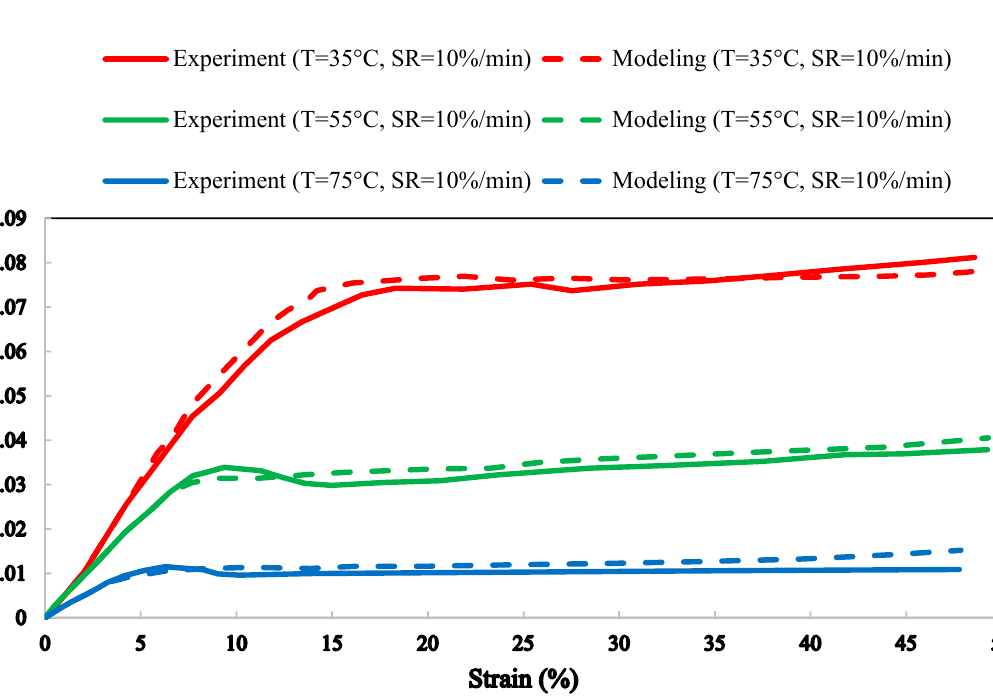
( c ) Figure 9. Stress distribution of PU SMP foams at different temperatures at the end of loading. The stress contours are related to the stress-strain results of the models illustrated in Figure 8 for ( a ) T=35 ℃ , ( b ) T=55 ℃ , and ( c ) T=75 ℃ . Next, the results of the model constructed based on [50] are presented in Figures 10 and 11. As can be seen, the stiffness of the PU foam decreases drastically by increasing the